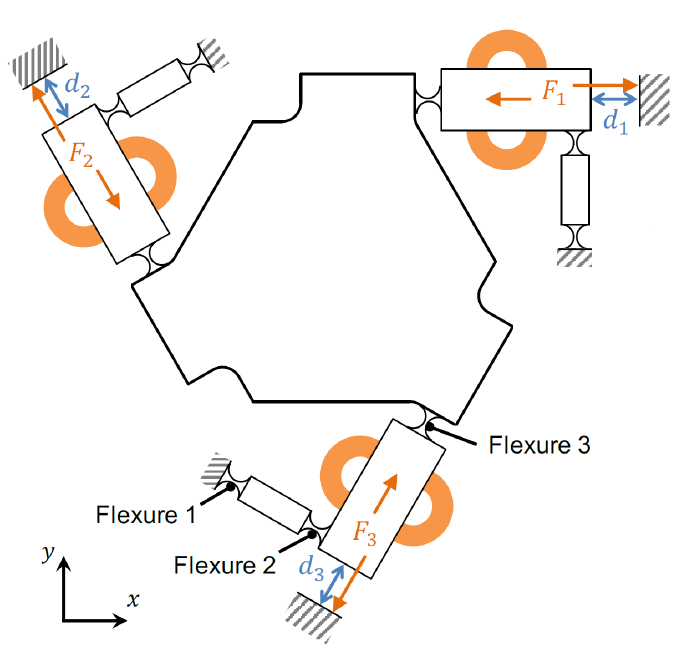
Figure 9. Compliant mechanism design used to house the Lorentz actuators. Adapted from [13].